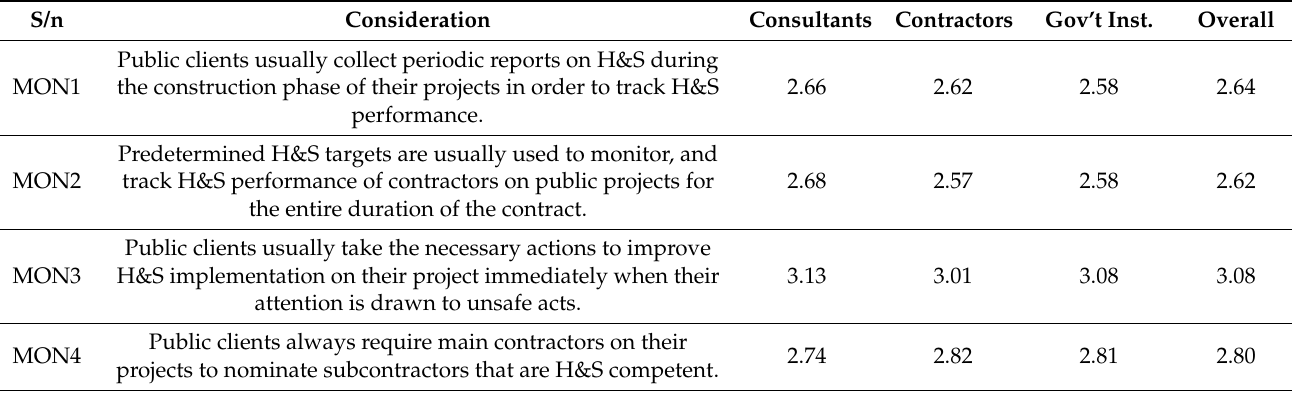
Table 14. H&S considerations in contract administration and monitoring.